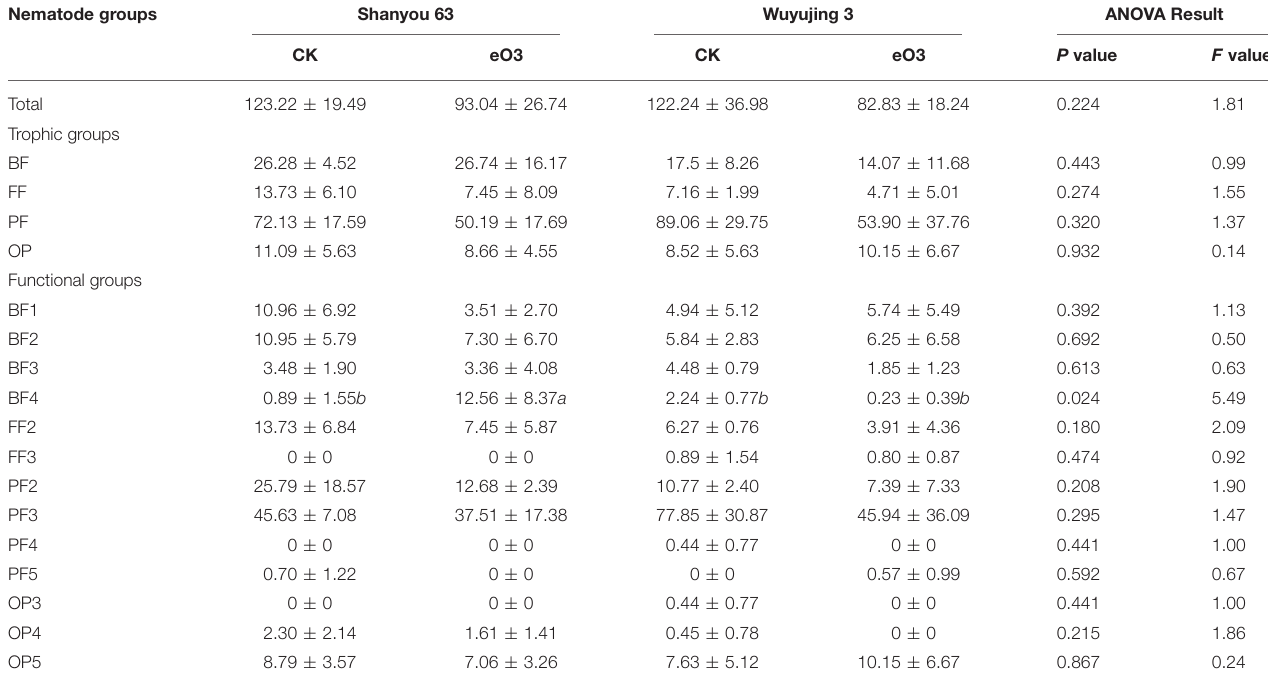
TABLE 2 | Changes in the abundance of soil nematodes (individuals per 100g dry soil) under elevated ozone conditions. Nematode